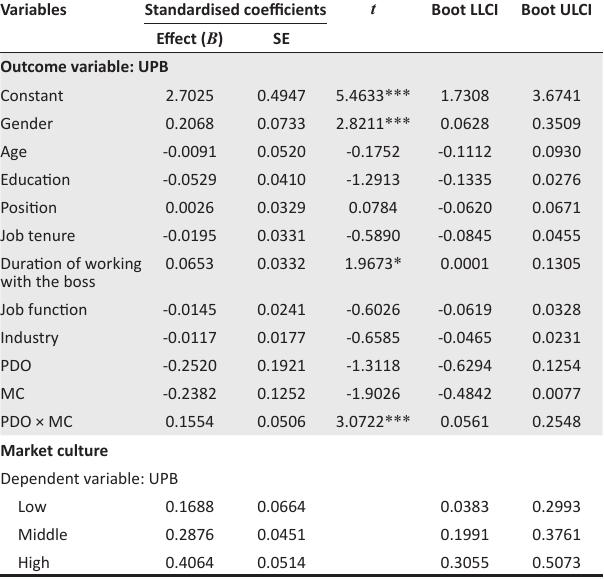
TABLE 6: Regression results for moderation effect on the relationship between power distance orientation and unethical pro-organisational behaviour. Variables Standardised coefficients